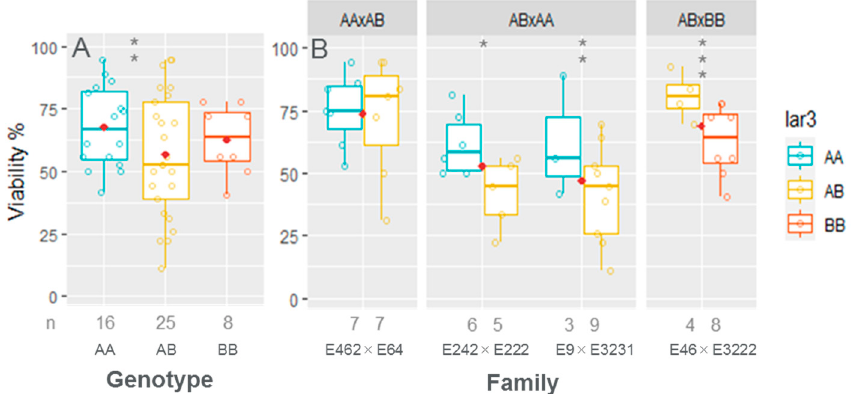
Figure 3. Embling viability (%) of different PaLAR3 genotypes ( A ) of four Norway spruce full-sib SE-families ( B ) in the end of first growing season with the number of SE lines given for each allelic combination ( n ). Asterisks denote differences between genotypes (* p < 0.05, ** p < 0.01, *** p < 0.001).